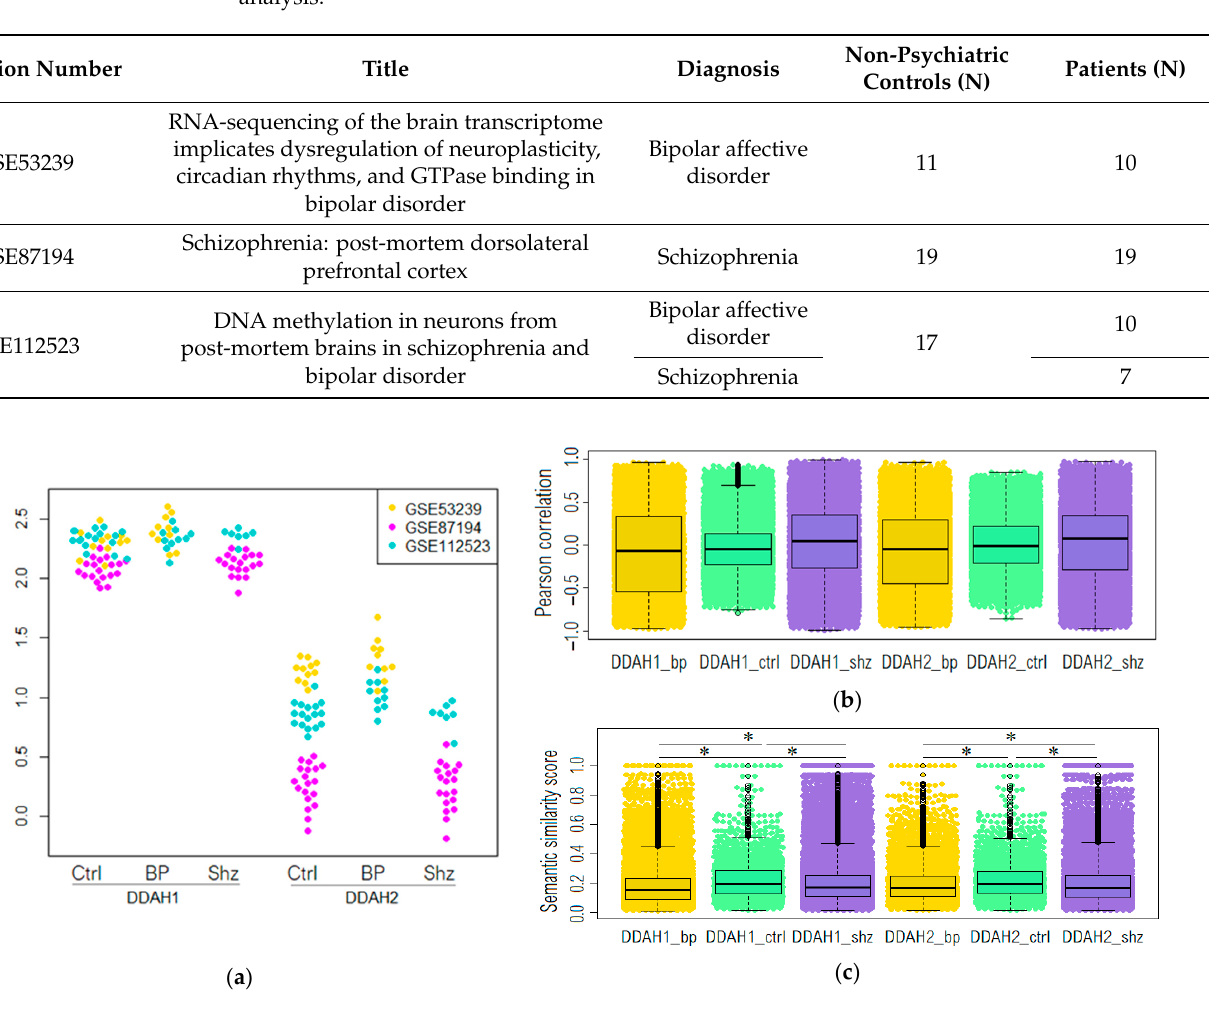
Table 1. Human transcriptomic GEO datasets meeting the inclusion criteria and included in the analysis.